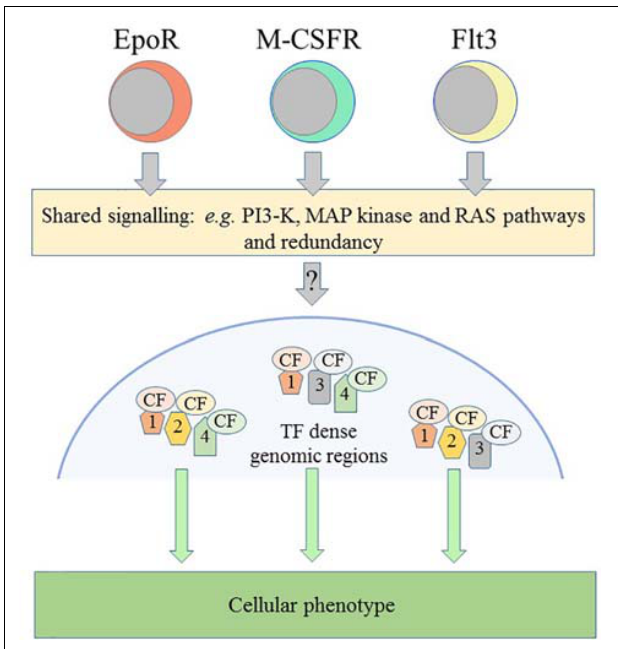
FIGURE 3 | Schematic representation of some of the controls on cellular phenotype. The receptors for erythropoietin (Epo) and for macrophage-colony stimulation factor (M-CSFR) and the fms-like tyrosine kinase 3 (Flt3) can instruct erythroid, macrophage and lymphoid/myeloid fates, respectively. Receptors share the use of signaling pathways and there is redundancy in their use. Various transcription factors, the colored shapes labeled 1, 2, 3, and 4, and their cofactors, the colored CF ovals, target and densely occupy certain genomic regions that are important for the specification of a cellular phenotype. PI3-K, phosphatidylinositol 3-kinase; MAP, mitogen-activated kinase.